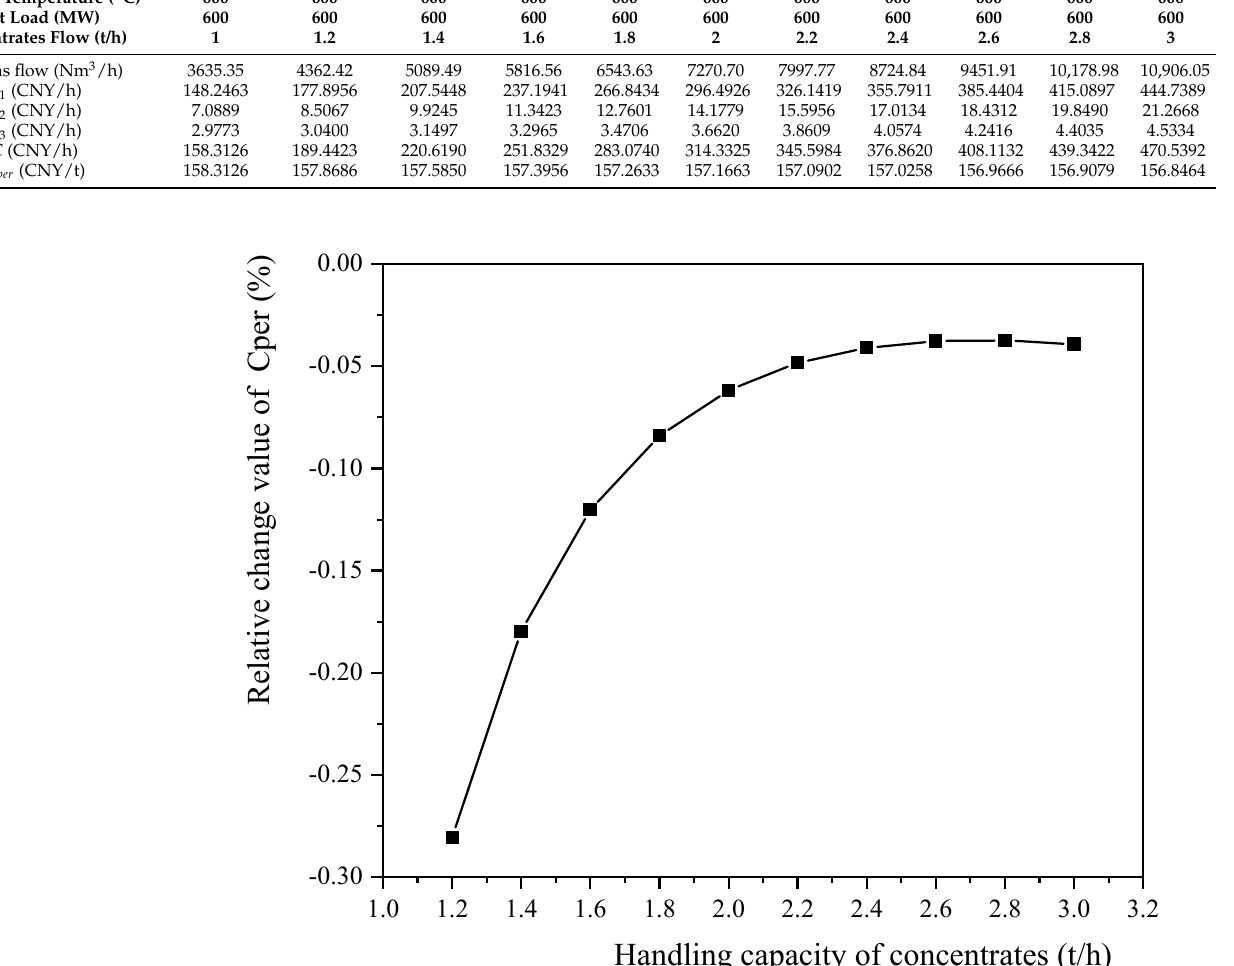
. (cid:3043)(cid:3032)(cid:3045)